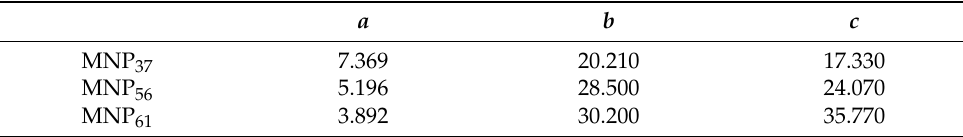
Figure 2. The T - t data of the MNP 37 ( a ), MNP 56 ( b ), and MNP 61 from reference [14] ( c ) at different initial temperatures (20–75 °C, 5 °C intervals); n = 4 for each line, data: mean value and standard uncertainty. ( d ) Experimental SLP data and fitted SLP - T curves of MNP 37 , MNP 56 and MNP 61 ; the SLP data of MNP 61 were from reference [14]; n = 4 for each point, data: mean value and standard uncertainty. Table 2. Gaussian fitting parameters of SLP - T curves for ZnCoCrFeO